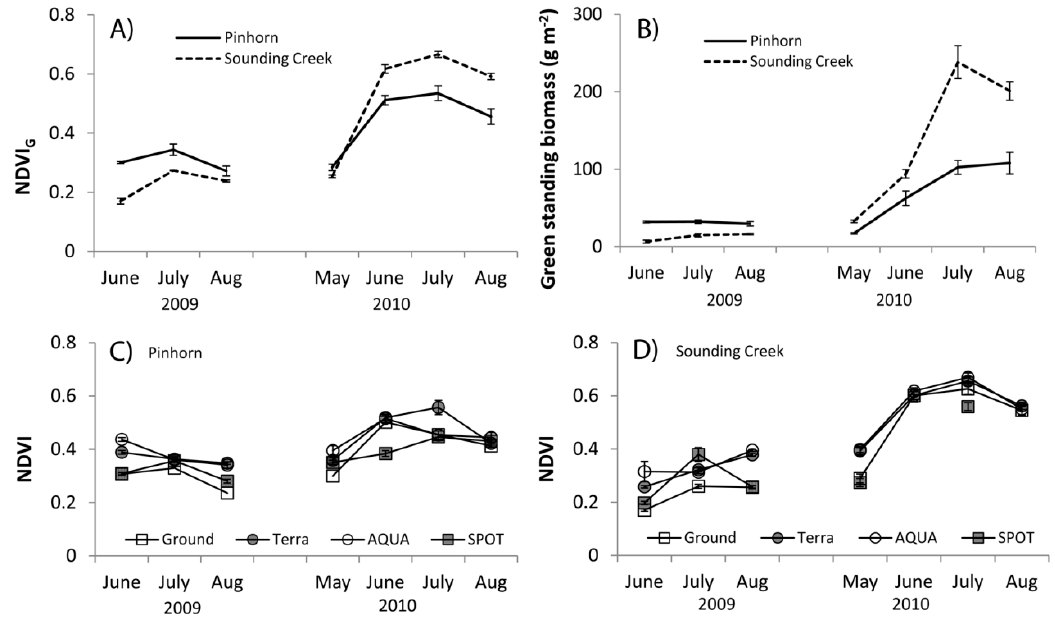
Figure 5. Time series of NDVI derived from ground spectrometry (NDVI G ) ( A ) and harvested green fraction of the standing biomass ( B ) from both grazing reserves as well as the time series of NDVI from ground spectrometer data, MODIS data from the Terra and Aqua platforms, and SPOT data from the Pinhorn grazing reserve ( C ) and Sounding Creek grazing reserve ( D ) during the summers of 2009 and 2010. Note that SPOT coverage was missing in June and August 2010 for Sounding Creek. For comparison, average NDVI values for bare soil were approximately 0.1 at these sites. Error bars denote the standard error of the mean.